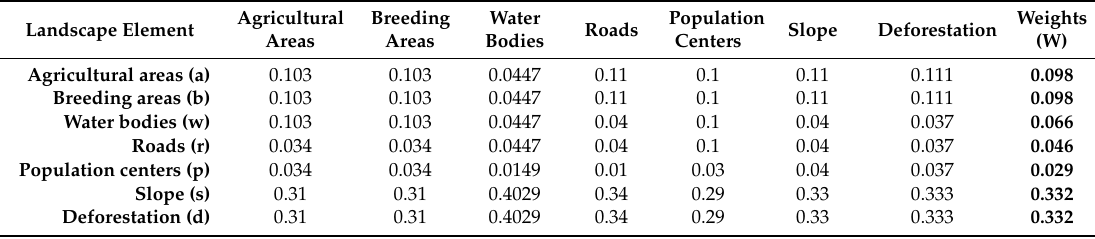
Table 5. Normalized comparison matrix and calculation of weights for hazard indicator (Hd) map